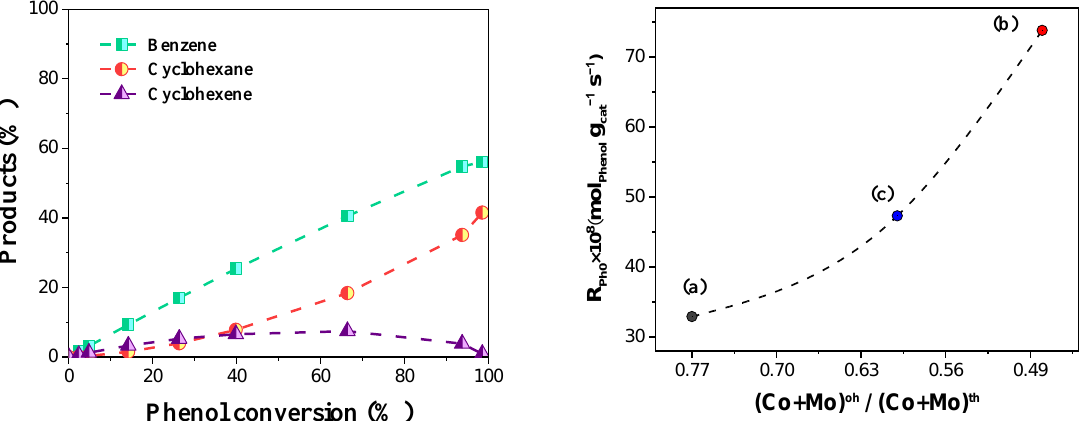
Figure 9. Distribution of products with respect to phenol conversion ( left ) and correlation between Figure 9. Correlation between the initial reaction rate and Co and Mo species during the HDO of phenol over a CoMoS/AT2 catalyst using different loading of Mo: (a) 10, (b) 12 and (c) 15 wt.%. the in-itial reaction rate and Co and Mo species ( right ) during the HDO of phenol over a CoMoS/AT2 Operating conditions: 320 °C and 5.5 MPa. catalyst using different loading of Mo: ( a ) 10, ( b ) 12 and ( c ) 15 wt.%. Operating conditions: 320 ◦ C and 5.5